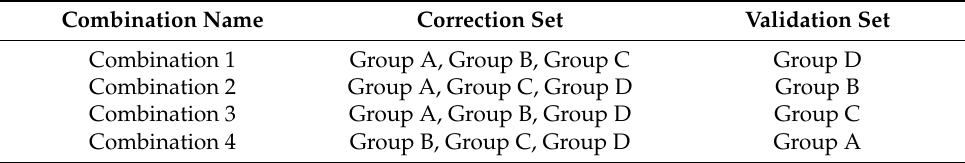
Figure 12. Hierarchical k-fold cross validation data grouping diagram. ( a ) Standard K-fold cross validation; ( b ) Stratified K-fold cross validation. Table 2. The combination results of different correction sets and verification